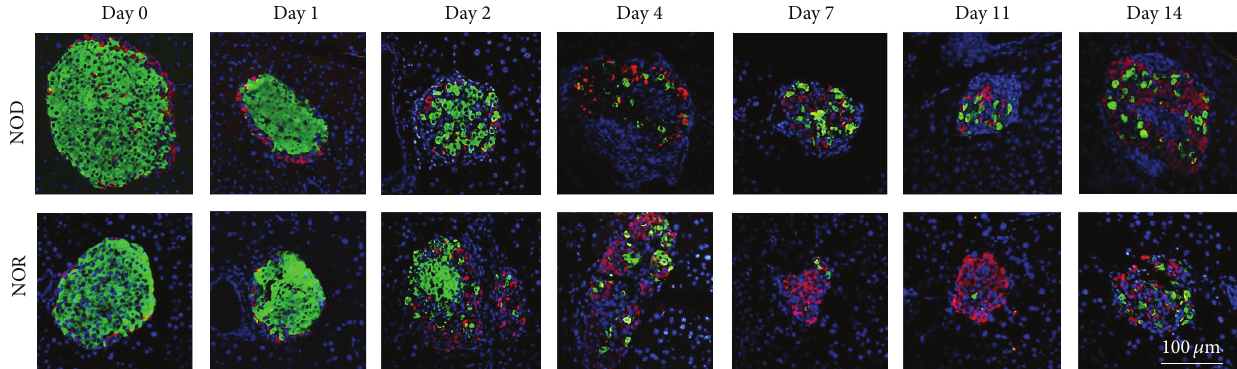
Figure 1: Changes in pancreatic islet content following STZ treatment. Representative images showing pancreatic islet contents in NOD (upper panel) and NOR mice (lower panel) before and after STZ application. Pancreatic tissues were stained with anti-insulin (green) and anti-glucagon (red) antibodies, and counterstaining was done with DAPI nuclear stain. Pictures represent islet images of pancreatic tissues isolated from animals sacrificed on day 0 (before STZ injection) and on days 1, 2, 4, 7, 11, and 14, after 150 mg/kg STZ injection ( 𝑛 = 3 for each time